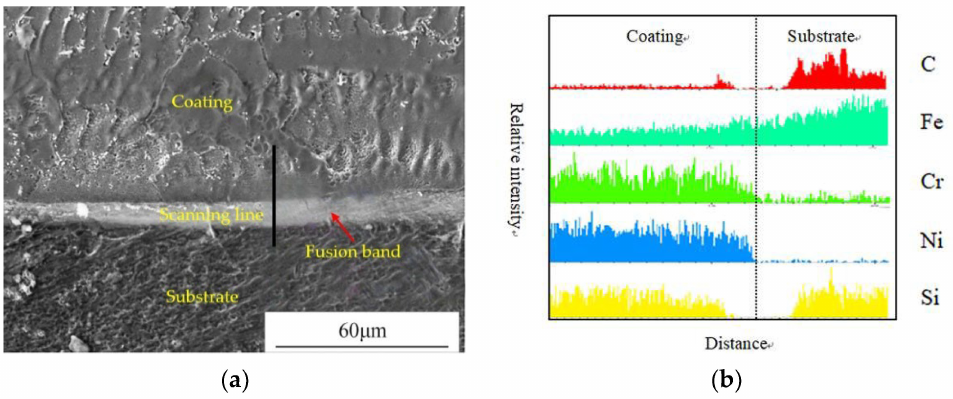
Figure 16. Interface binding analysis: ( a ) combined morphology, and ( b ) line scanning energy spectrum